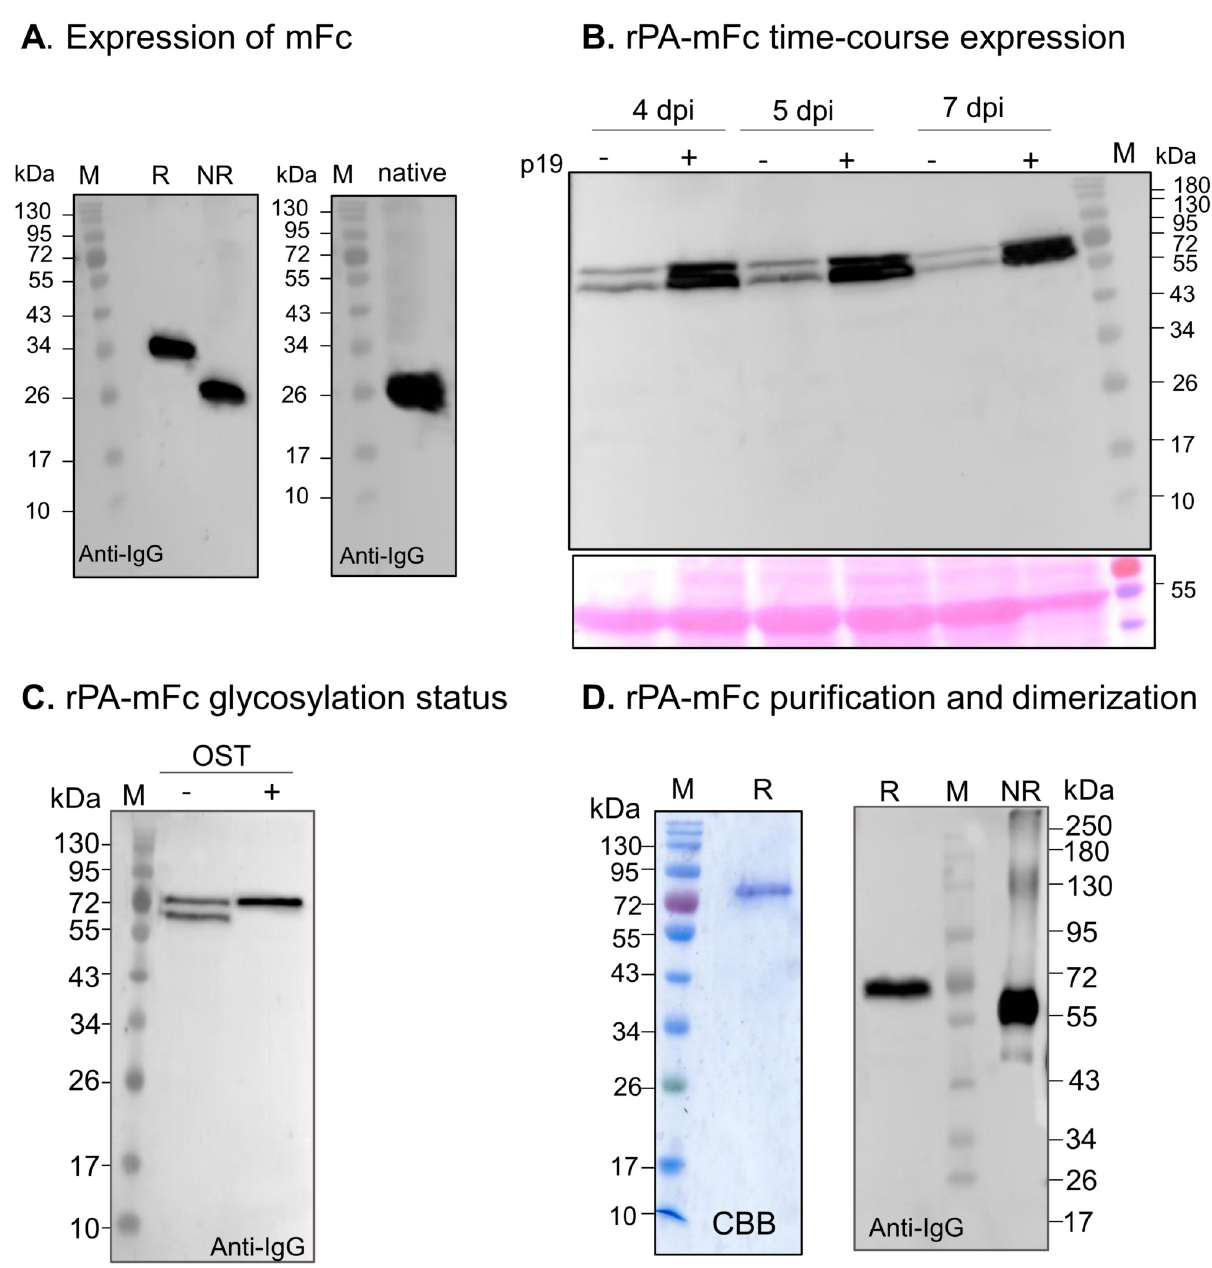
Fig 5. Expression of monomeric rPA-Fc fusions in N . benthamiana . (A) Total soluble proteins extracts (TSP) from N . benthamiana Δ XF leaves expressing mFc (non-fused) were analysed in 12% SDS-PAGE under reducing (R) and non-reducing (NR) conditions and in native PAGE with anti- hIgG antibodies. (B) TSP from N . benthamiana Δ XF leaves expressing rPA-mFc co-expressed with (+) or without (-) p19 were analysed in 12% SDS-PAGE under reducing conditions with anti-hIgG antibodies at different days post infiltration (dpi). Ponceau staining shows similar amounts of protein loaded. (C) rPA-mFc was expressed in N . benthamiana Δ XF with (+) or without (-) co-expression of an oligosaccharyltransferase from Leishmania major (OST). TSP were analysed in 12% SDS-PAGE under reducing conditions with anti-hIgG antibodies. (D) rPA-mFc purified out of TSP with Protein G was stained with Commassie brilliant blue under reducing conditions (CBB) (left panel) and analysed in 8% SDS-PAGE under reducing (R) and non-reducing (NR) conditions with anti-hIgG antibodies (right panel). Protein size markers are shown in kilo Dalton (kDa).